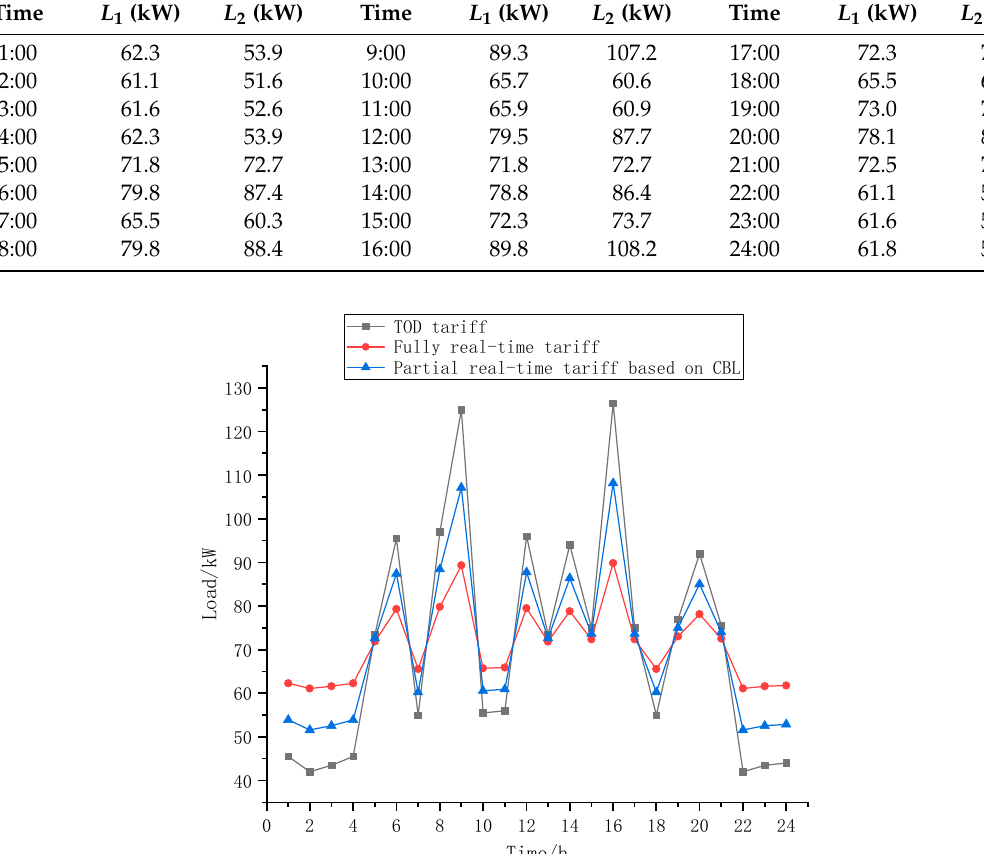
Table 8. User’s load response with real-time price.